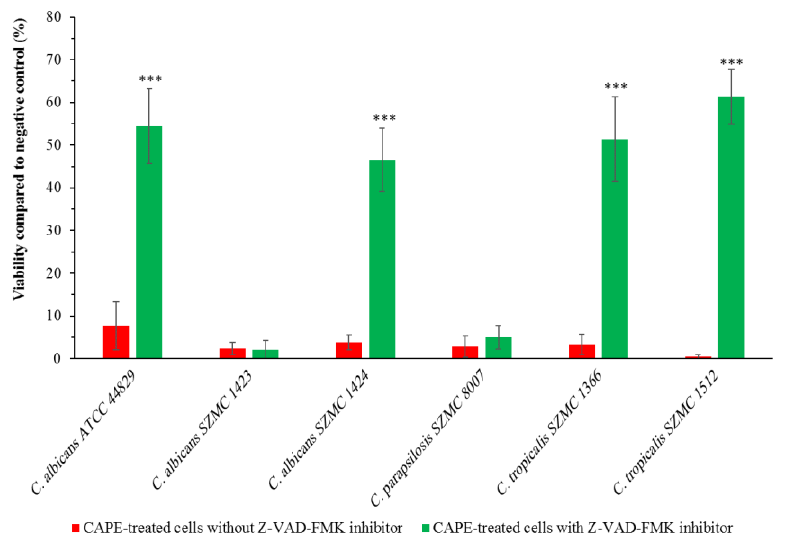
Figure 5. Effect of the pan-caspase inhibitor Z-VAD-FMK on the viability of six Candida strains treated with sub-lethal concentrations of CAPE. Data are shown as mean ± SD from three independent experiments. *** p <0.001 indicates a significant increment of the viability compared with the viability without pre-incubation with the pan-caspase inhibitor Z-VAD-FMK.